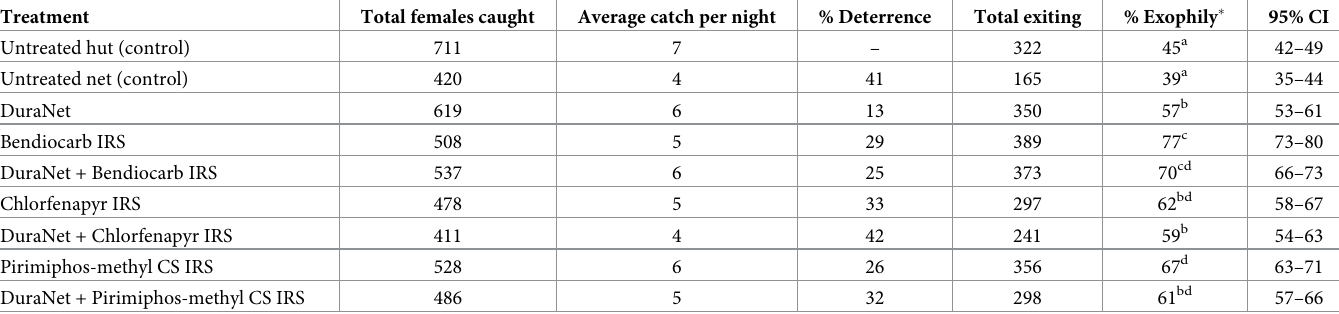
Table 3. Overall entry and exiting of wild, pyrethroid-resistant Anopheles gambiae sensu lato entering experimental huts in Cov è , southern Benin. Treatment